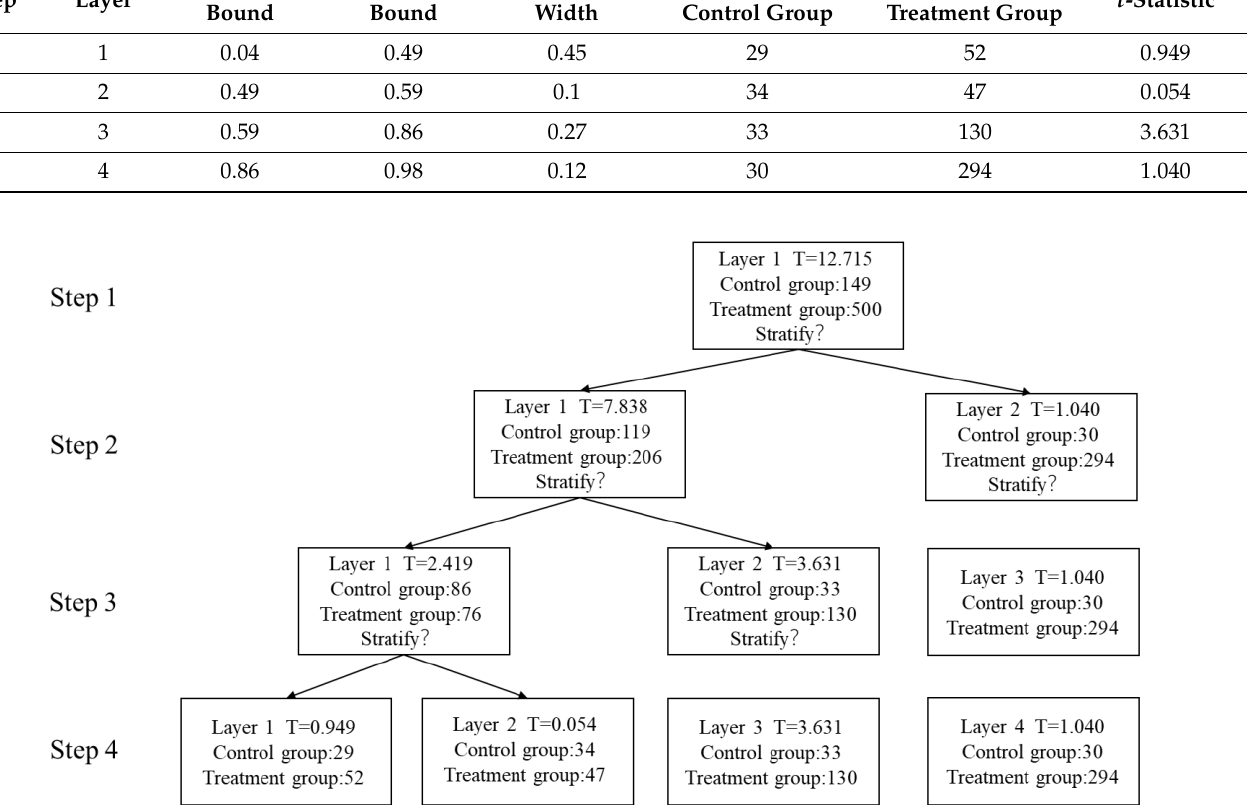
Figure 4. The process of stratification in this case study.